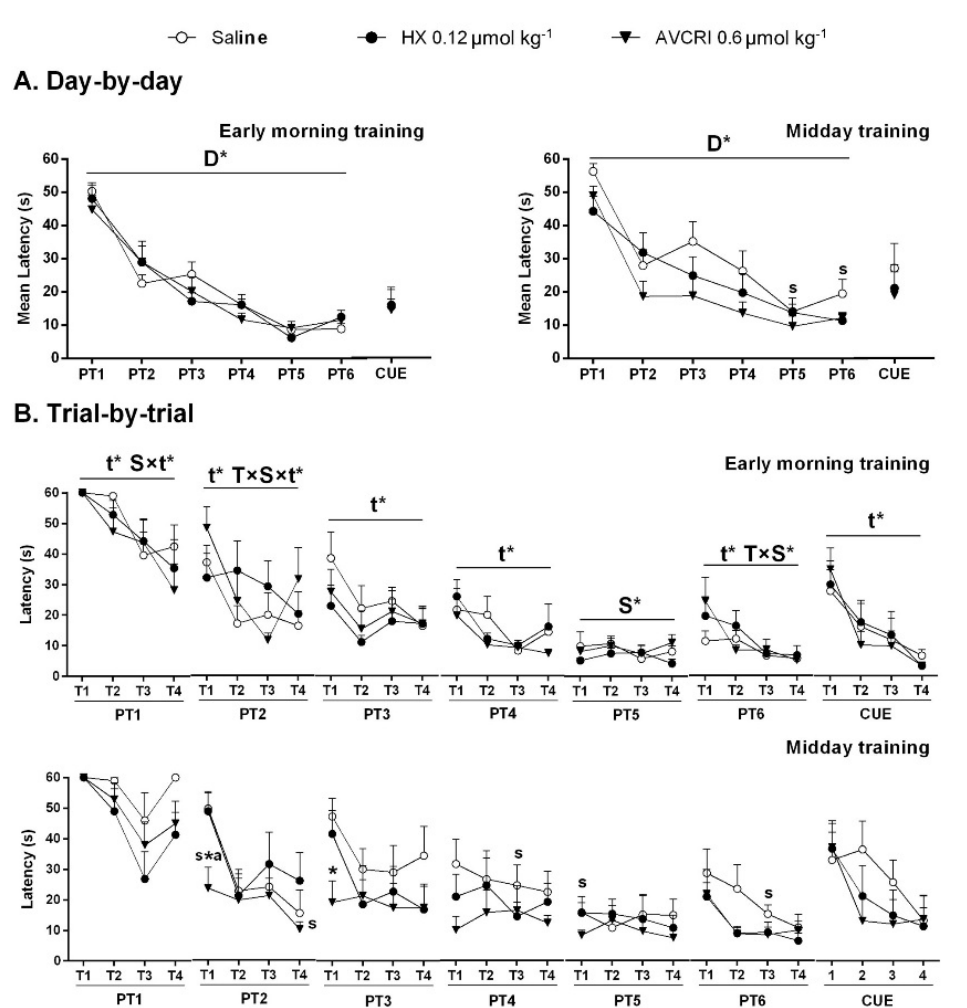
Figure 1. Effects of HX and AVCRIP104P3 on cognitive performance of 3xTg-AD mice in acquiring the place task and cue. Results are expressed as mean ± SEM ( n = 7 in each group). ( A ) Day-by-day total mean latency to reach a hidden (PTn) and visible (CUE) platform. ( B ) Trial-by-trial latency to reach the platform in each of the four trials (T1–T4) per session. Statistics: Split plot ANOVA: T ‘treatment’, S ‘schedule’, D ‘day’, t ‘trial’, T × S ‘treatment × schedule’, S × t ‘schedule × trial’, T × S × t ‘treatment × schedule × trial’ effects, * p < 0.05. Post hoc Bonferroni: * p < 0.05 vs. the same schedule saline group, a p < 0.05 vs. the same schedule HX group, s p < 0.05 vs. the same treatment early morning training